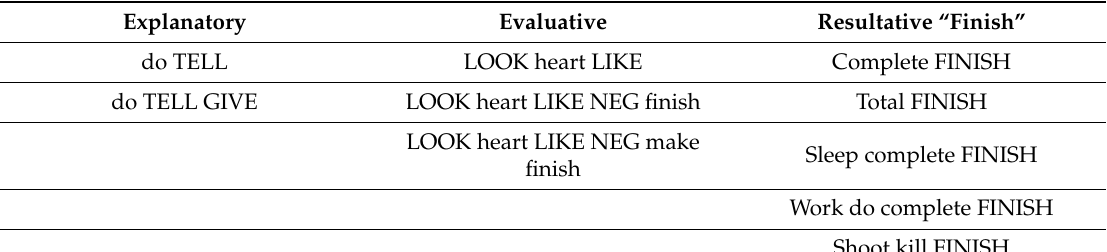
Table 5. Serial verbs in